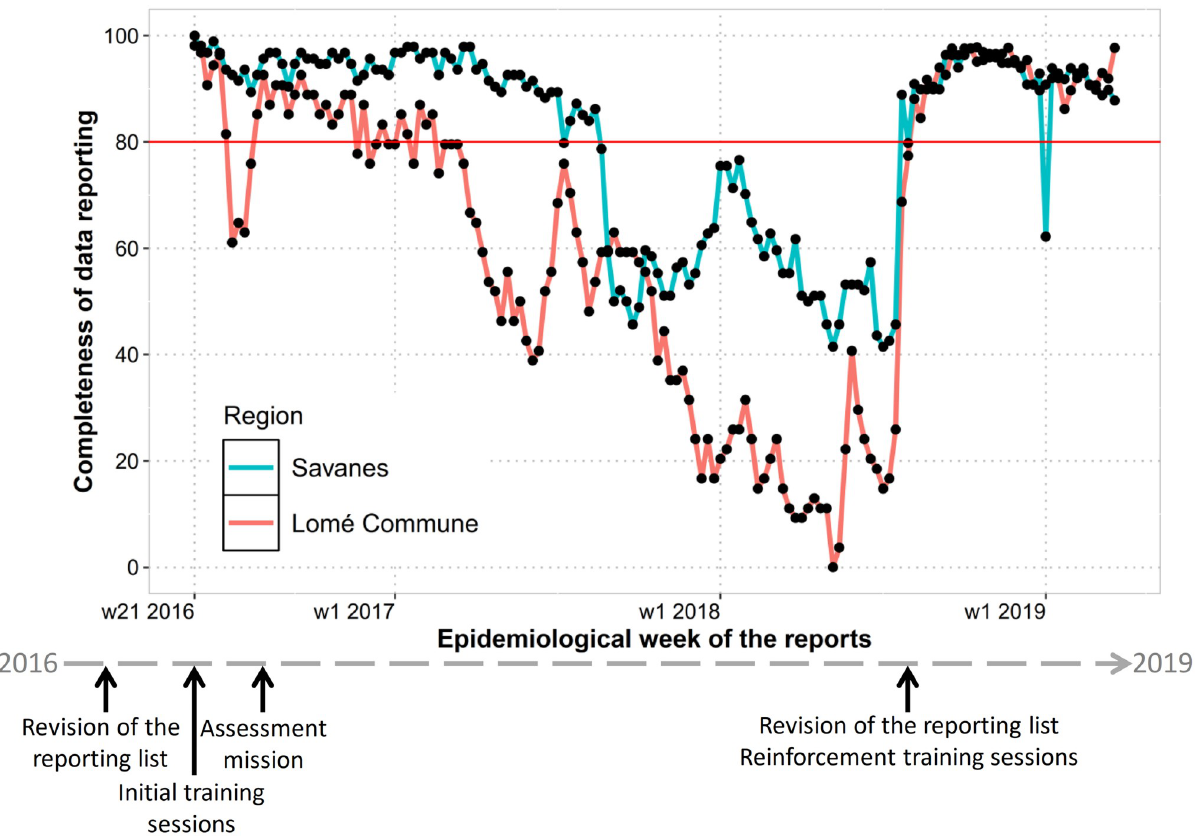
Fig 2. Evolution of completeness of data reporting by healthcare facilities from week 21 2016 to week 12 2019 (n = 23 062 expected reports).